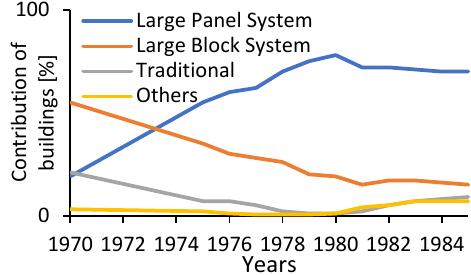
Figure 7. Contribution of buildings in years 1970–1985 in Poland (based on the information provided in [17]) .